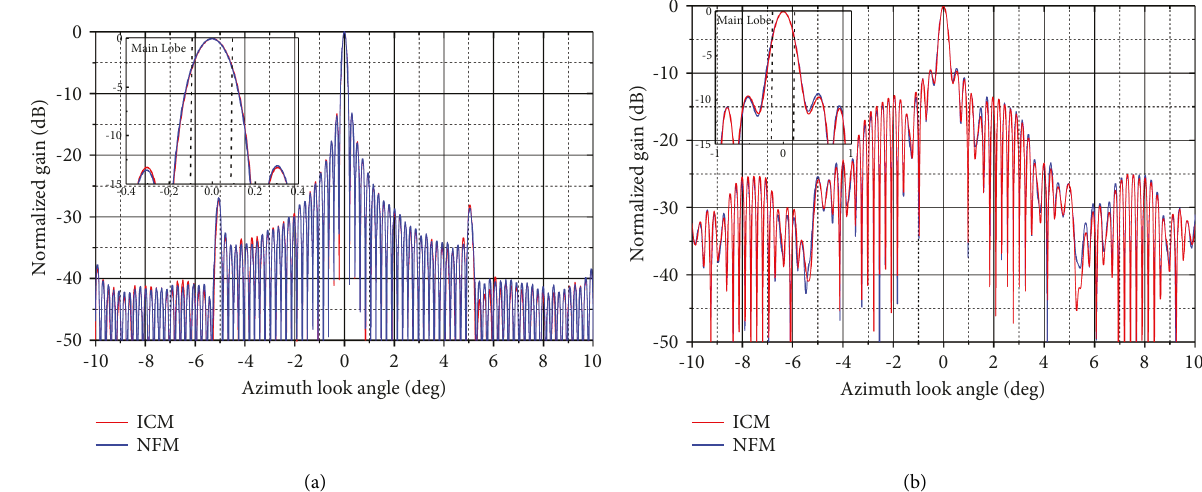
Figure 8: Azimuth pattern comparison of the internal calibration method (ICM) to the near-field method (NFM). (a) Boresight beam; (b) Beam broadening 1.7 times. The inserts are the zoomed plots of the main lobe.